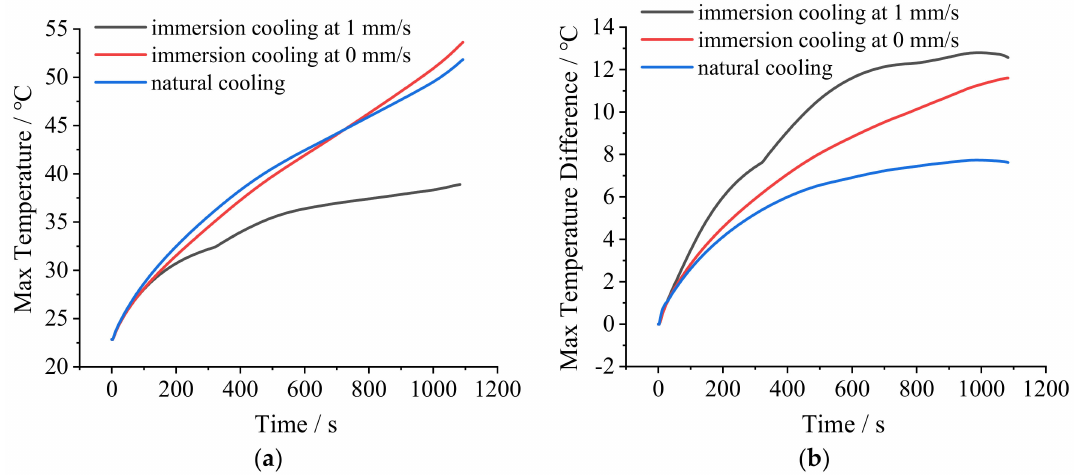
Figure 8. ( a ) MAT of the cell during 3 C discharging; ( b ) MATD of the cell during 3 C discharging.